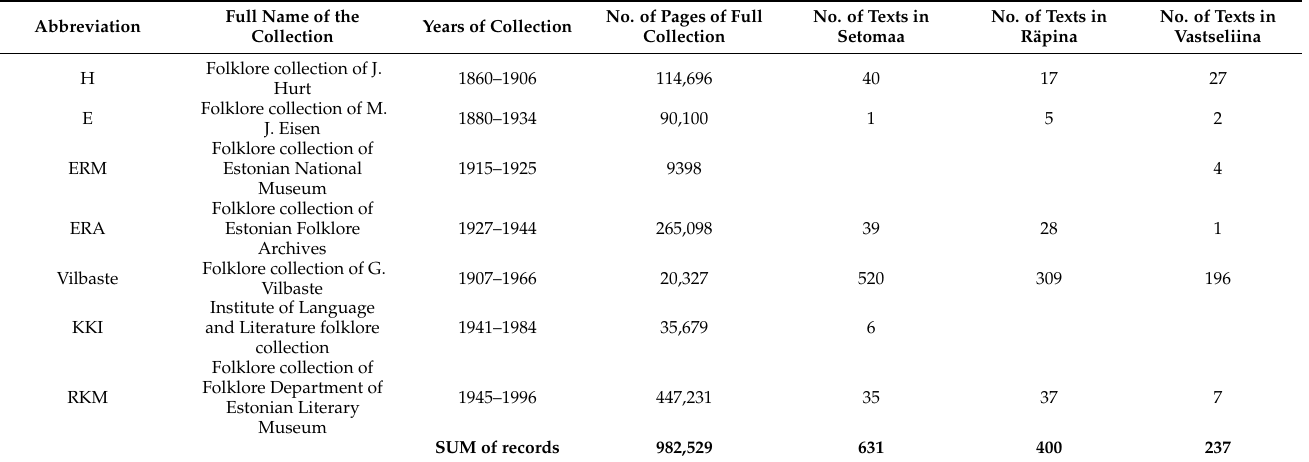
Table 4. Folklore collections and the number of pre-selected text segments from every